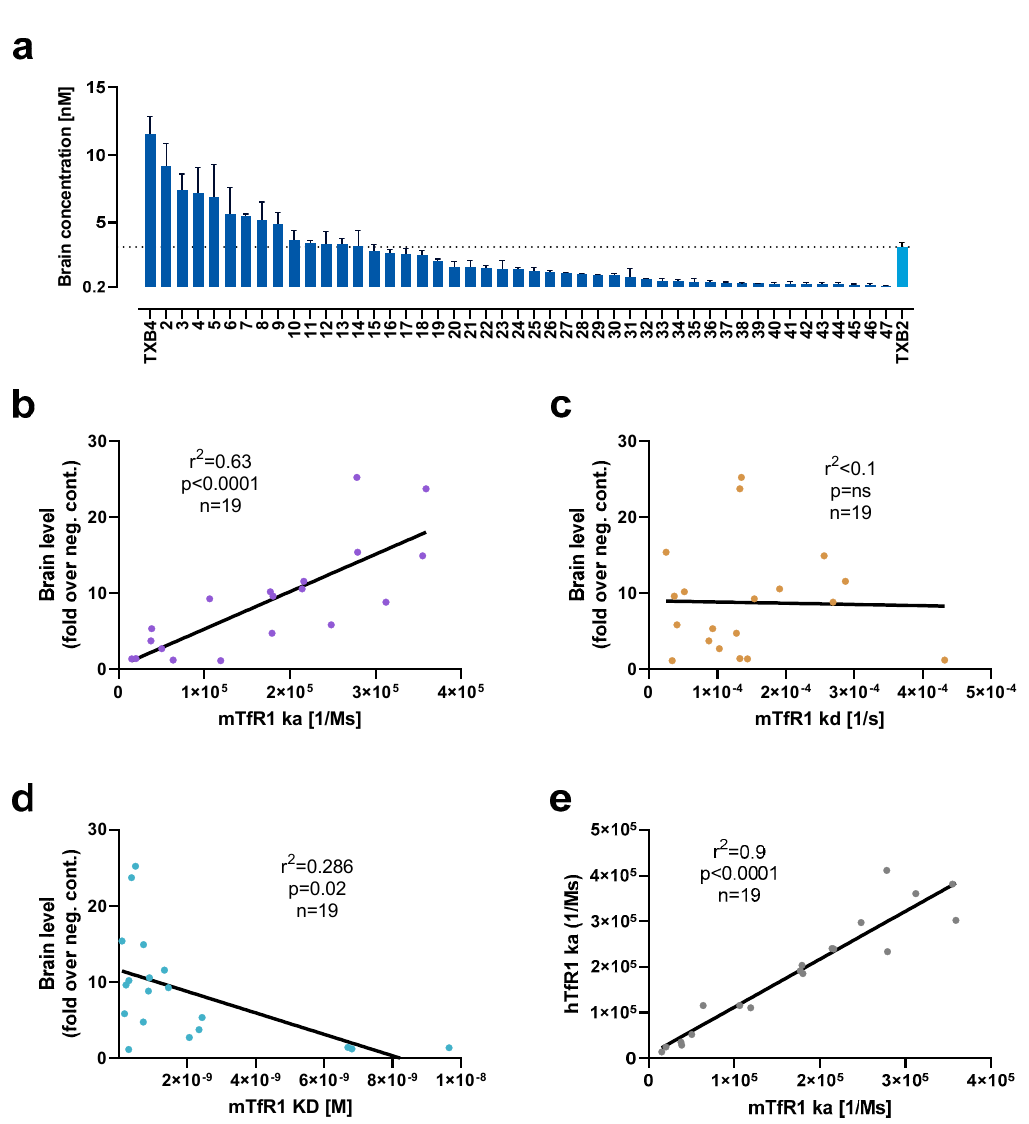
Figure 2. Functional activity of TXB2 variants in vivo correlates with TfR1 association rate in vitro. ( a ) A panel of 47 TXB2 variants were tested for brain penetration in mice at a dose of 25 nmol/kg (1.875 mg/kg), IV, and brain levels were measured at 18 h timepoint via ELISA (mean ± SD, n = 3). Levels of parental TXB2 and a negative isotype control (0.2 nM) at the same dose were used as references. TfR1 binding kinetics of 19 TXB2 variants selected for either low and high brain levels were assessed via SPR. ( b ) Association rate (ka), ( c ) dissociation rate (kd) and ( d ) affinity (KD) were independently correlated using Pearson’s method with the brain levels normalized to fold over negative control (neg. cont.). ( e ) Pearson’s correlation of the ka between hTfR1 and mTfR1 for the 19 TXB2